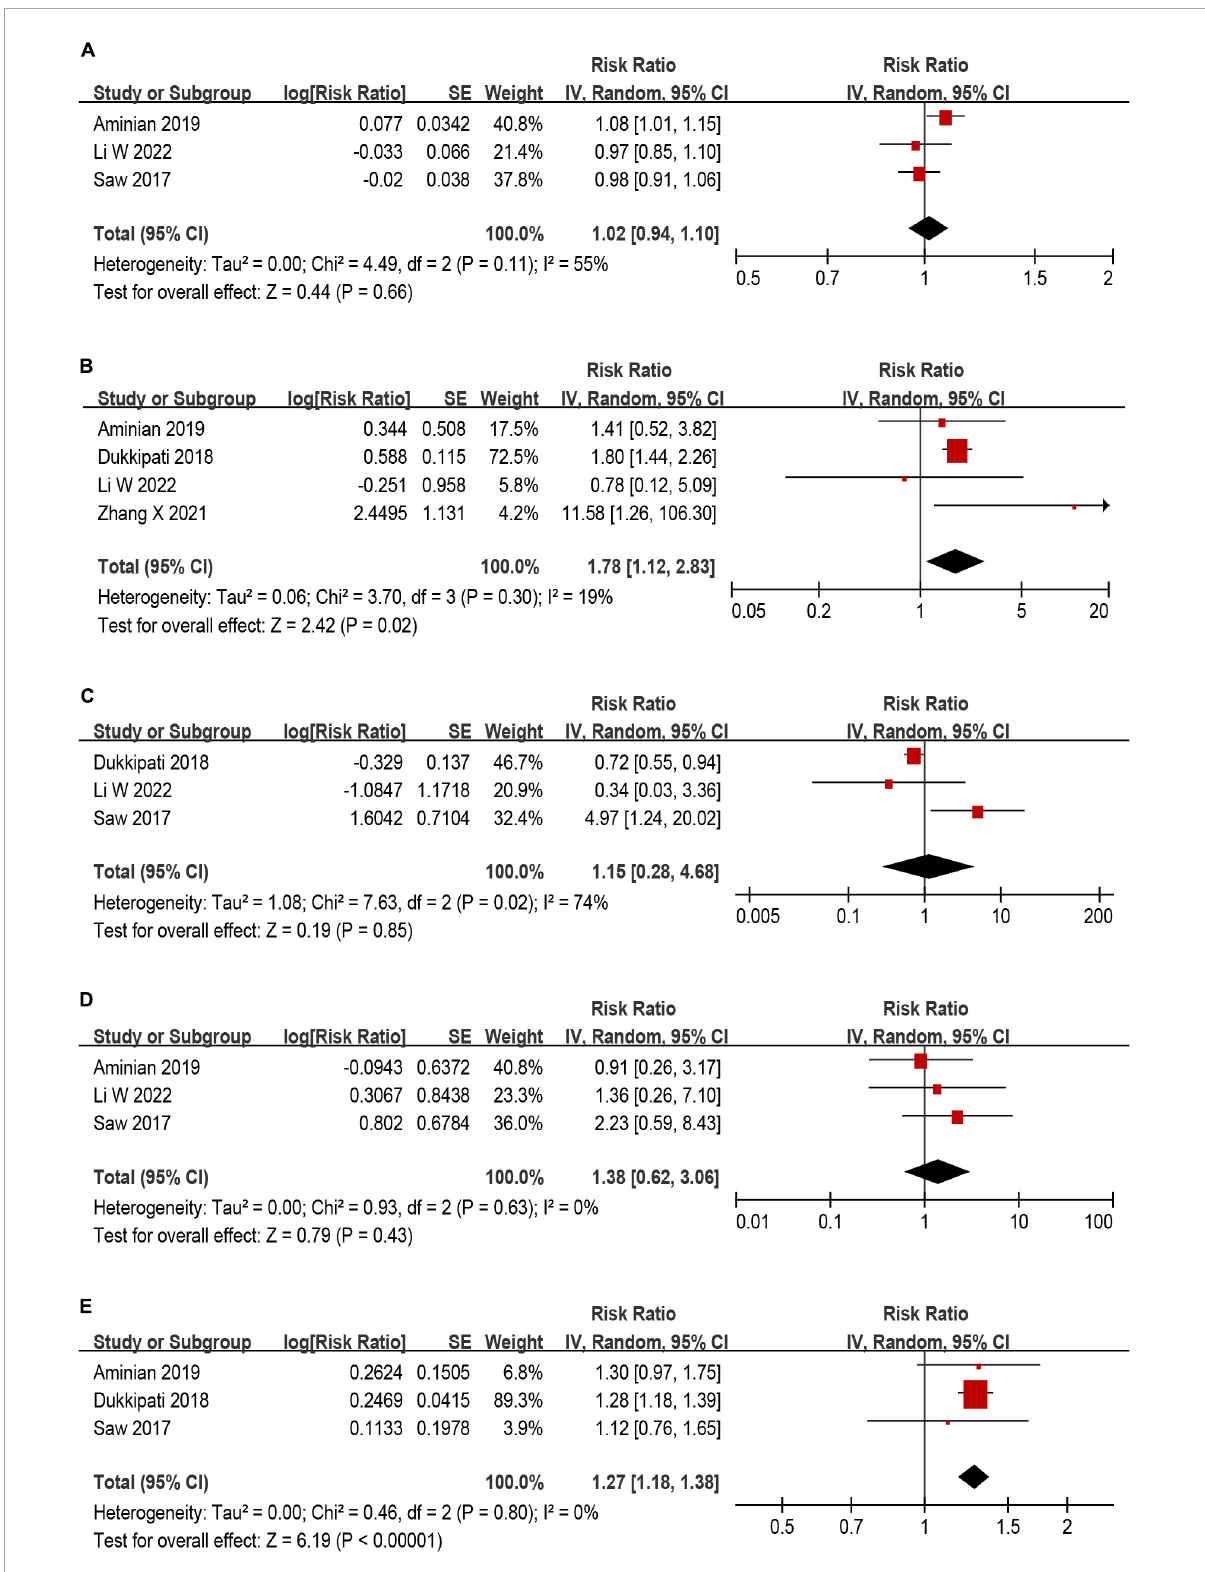
FIGURE6 Forest plot of risk ratios (RR) for (A) age, (B) history of stroke/TIA, (C) smoking, (D) hypertension, and (E) CHA 2 DS 2 –VASc score as predictors for device related thrombus